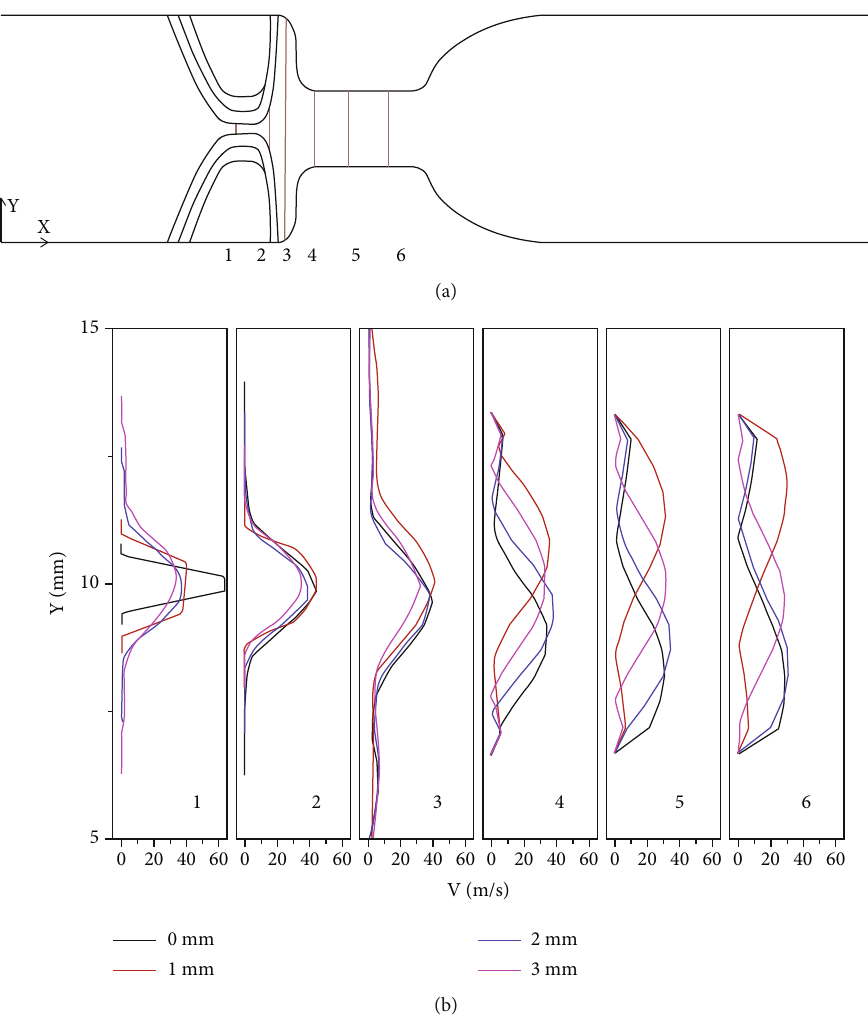
Figure 6: Total velocities, plotted along the six lines located in the X-Y